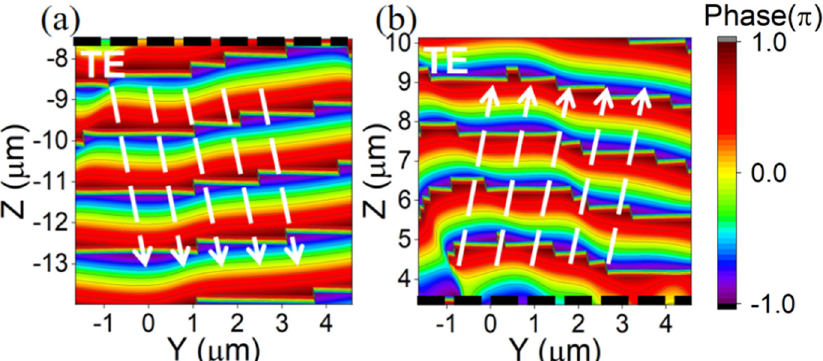
Figure A3. The Y − Z plane phase diagrams of the reflective and transmissive ends of the metasurface beam splitter under two types of line-polarized incident light at 1.55 µ m wavelength reflect the isophase plane of the outgoing light waves, with white arrows in the direction of the isophase plane vertical line, a black dashed line being the light-emitting surface of the metasurface, and different color stratifications representing different isophase planes. ( a ) The isophase plane of the reflective end under the incident x-line polarized light. ( b ) The isophase plane of the transmissive end under the incident x-line polarized light. As can be seen from the above figures, since the unit cell structure under the FIT method simulation shows a similar phase change as under the FDTD method simulation, the FIT method simulation results also exhibit an isophase plane tilt at the transmissive and re fl ective ends.